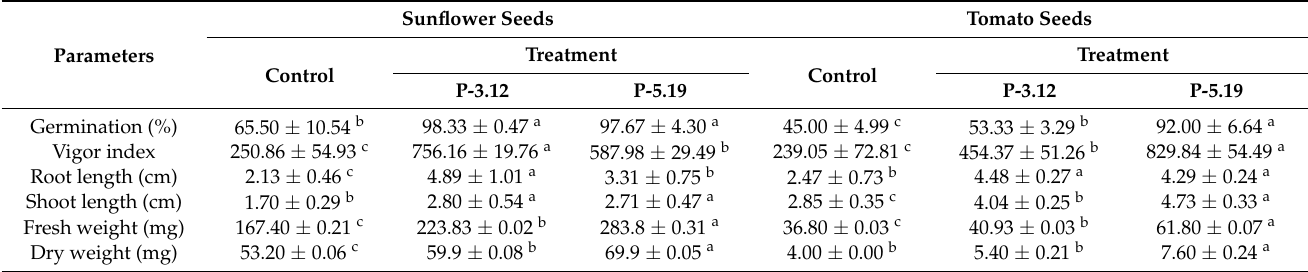
Table 3. Effects of Pseudarthrobacter enclensis P-3.12 and Curtobacterium citreum P-5.19 viable cells on sunflower and tomato seed germination and growth parameters under in vitro axenic conditions.